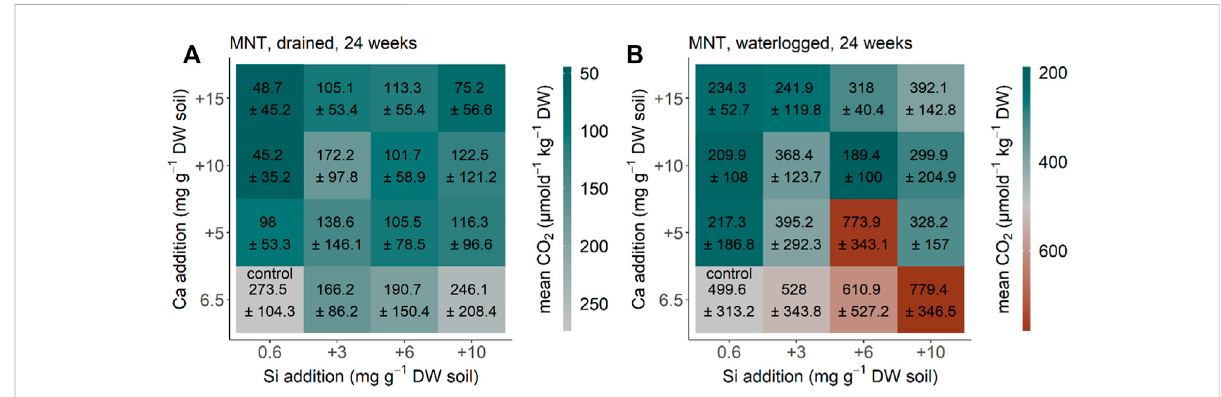
FIGURE 4 CO 2 production for the MNT soil from moist non-acidic tundra, Alaska after 24 weeks (A) drained and (B) waterlogged incubation. Each square represents a treatment (n = 5) with Si (+0, +3, +6, and +10 mg g − 1 DW) and Ca (+0, +5, +10, and +15 mg g − 1 DW). Color represents mean and standard deviation of CO 2 production.